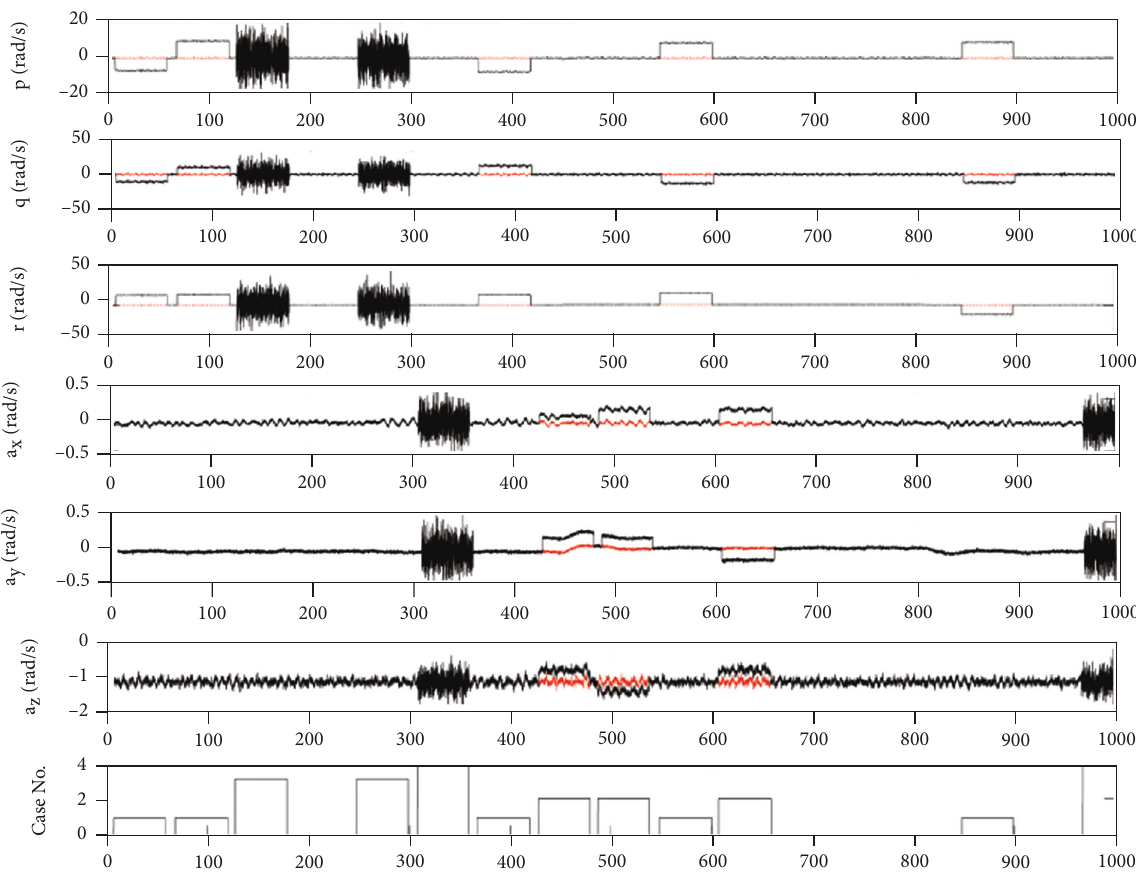
Figure 2: Example of fault